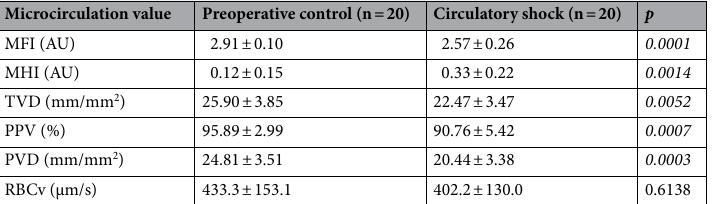
Table 3. Sublingual microcirculation of preoperative control subjects compared to patients with postoperative shock. Values are given as the mean ± SD. Significant values are in